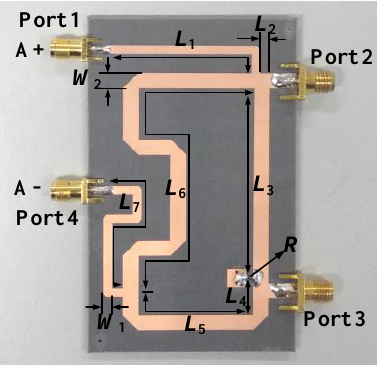
Figure 7. Photograph of the fabricated 20-dB BTU power divider. Table 2. Dimensions of the prototype II (unit: mm; referring to Figure 7).